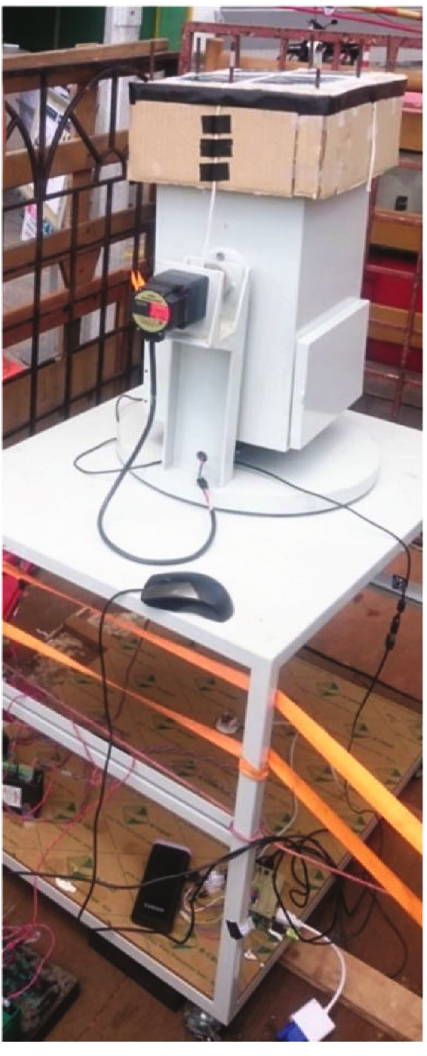
Figure 18: Experiment setup of prototype mobile sun-tracking system on a small truck to measure pointing error under moving